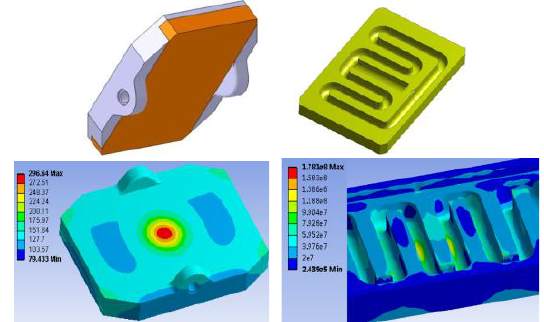
Fig. 5. (Upper) The cooling design of the mobile mirror, (Lower) the temperature and the stress distributions of the mirror.